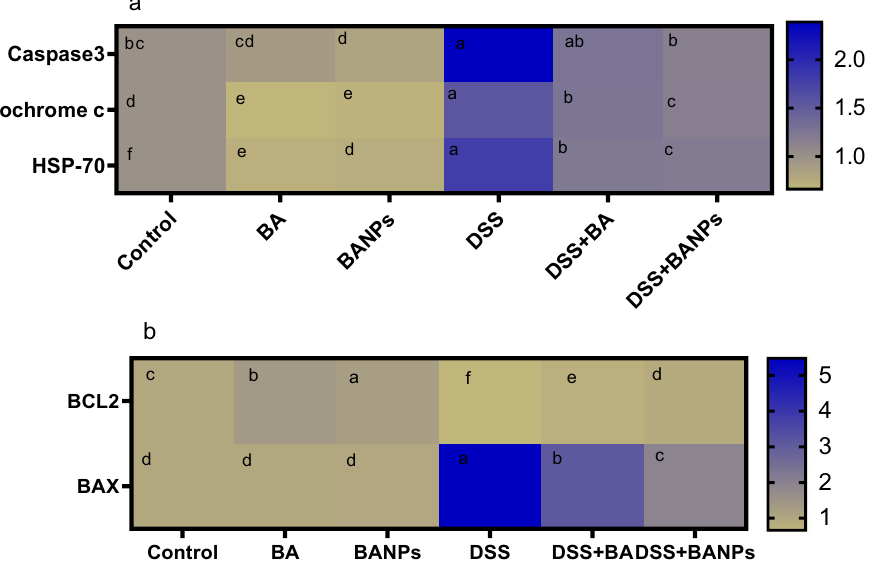
Figure 6. Heat map illustrating the effects of orally administered B. amyloliquefaciens (BA) or BA-nanoparticles (BANPs) in non-colitic and colitic rats on mRNA expression of caspase-3, heat shock protein-70 (HSP-70), Cytochrome c, Bax and Bcl-2, 7 days post DSS induction. Non-colitic groups including Control, BA and BANPs groups where rats were orally gavaged PBS, B. amyloliquefaciens and B. amyloliquefaciens loaded nanoparticles (BA at level of 1.0 × 10 10 CFU/kg in 1 mL of PBS/rat/day), respectively, for 7 days. Colitic groups: DSS, BA and BANPs groups where rats were orally gavaged dextrane sodium sulphate (DSS), B. amyloliquefaciens + DSS and B. amyloliquefaciens loaded nanoparticles (BA at level of 1.0 × 10 10 CFU/kg in 1 mL of PBS/rat/day) + DSS , respectively, for 7 days. All groups orally gavaged by 5% DSS. Values are expressed as mean ± SE, a,b,c Means of the bars with different letters were significantly different among groups ( P < 0.05). The scale bar on the right side described the unit for each color as blue and light green squares corresponded to significant upregulation and downregulation of genes relative to the control groups (P < 0.05).